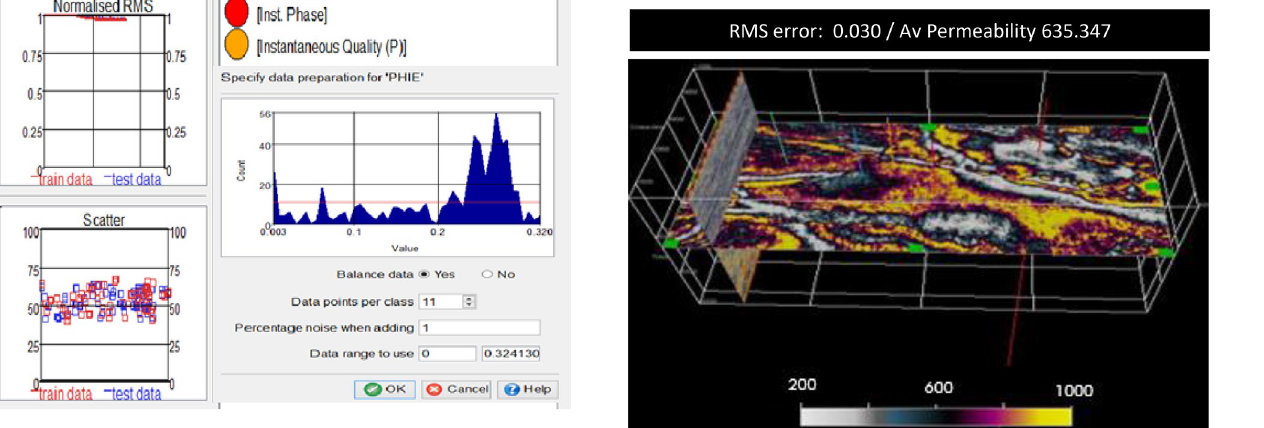
Fig. 16 Permeability time slice at top of reservoir